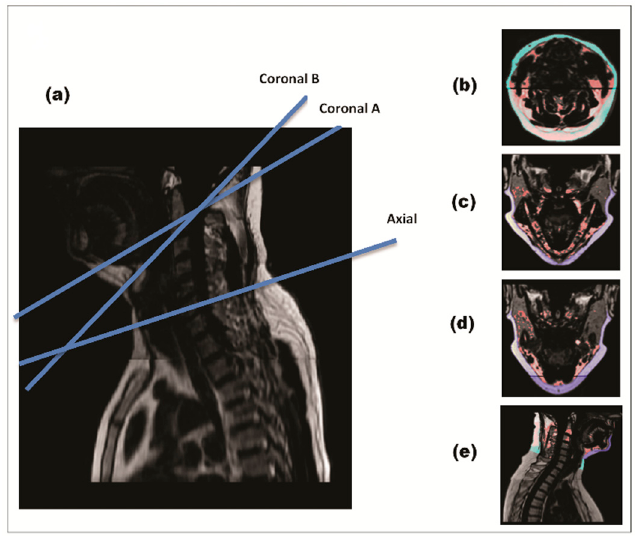
Figure 2. MRI of cervical-subcutaneous-adipose-tissue. Four anatomical slices per subject were extracted for each time point in each time. During quantification, cervical-SAT was divided into two sub-compartments—chin-SAT (dark blue) and cervical-SAT (light blue). Image ( a ) demonstrates a mid-sagittal section of the cervical region with blue lines placing the two coronal and axial sections. Image ( b ) demonstrates an axial slice, Image ( c ) coronal A slice, Image ( d ) coronal B slice and Image ( e ) sagittal slice.